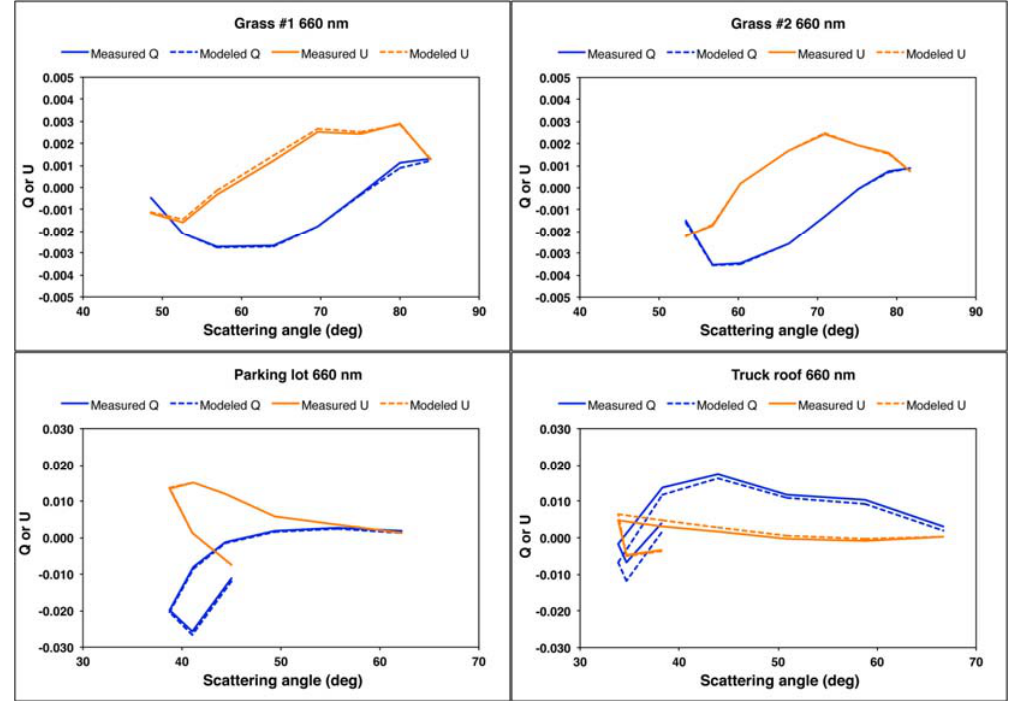
Figure 14. Similar to Figure 7, but with the modeled Q and U obtained from Step